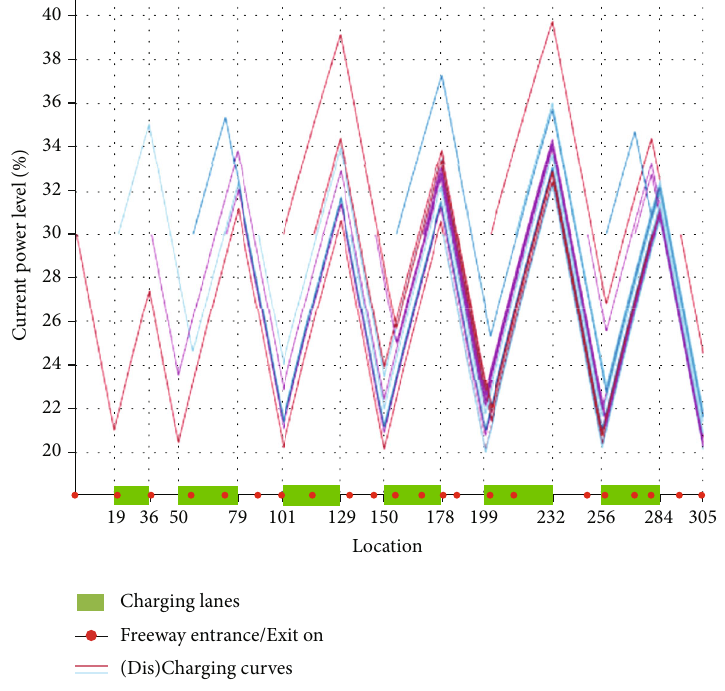
Figure 9: Discharging and charging curves for u ∈ U .